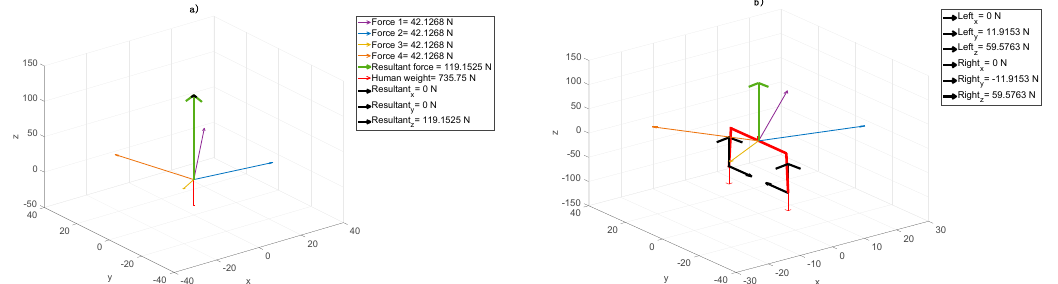
Figure 3. Elastic cord force values in the SPIDER cage, in case of a human with a mass of 75 kg and the following setup: ( a ) elongation cords from 1 to 4—250 mm, and cord and centre of gravity (COG) level angles from 1 to 4—45 ◦ ; ( b ) elastic cord forces and foot reaction values in the xyz directions.